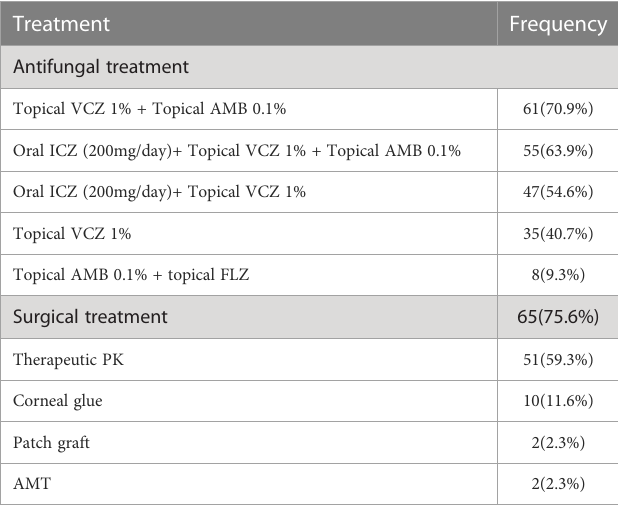
TABLE 4 Treatment of fungal keratitis in studied patients.